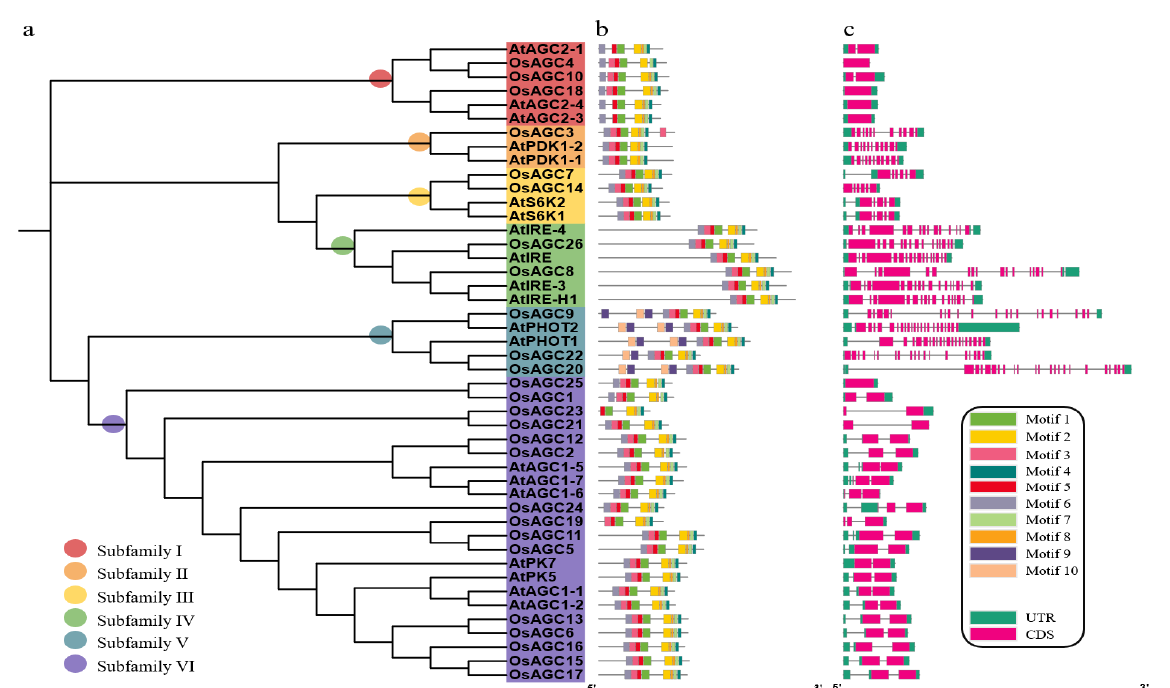
Figure 2. Phylogenetic relationship, gene structure and conserved motifs of AGC family members. ( a ) Phylogenetic relationship of AGCs in rice and Arabidopsis . ( b ) Structure of exons and introns of AGCs , exons and introns were represented using rectangles and bars, respectively. ( c ) Distributions of conserved motifs.